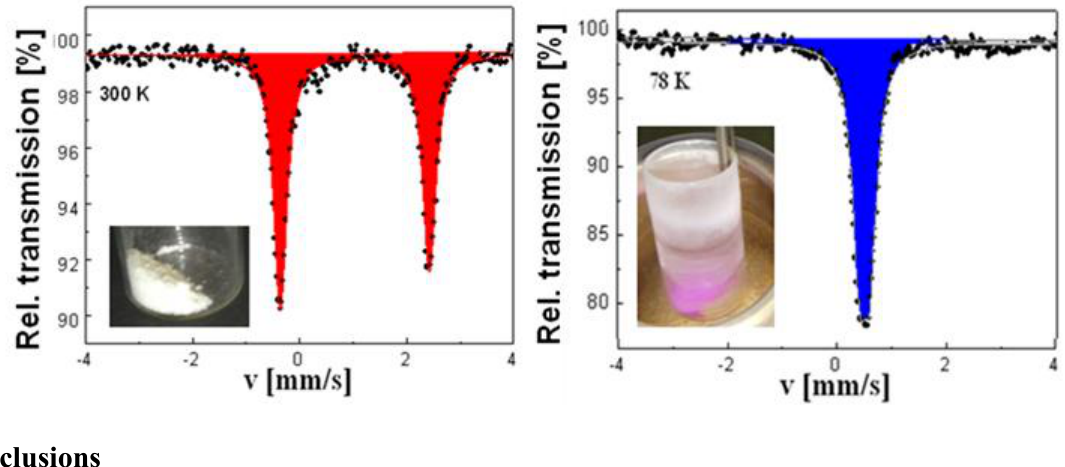
57 Fe Mossbauer spectra at 300 K and 78 K showing spin crossover and Figure 9. Selected associated thermochromism in 5